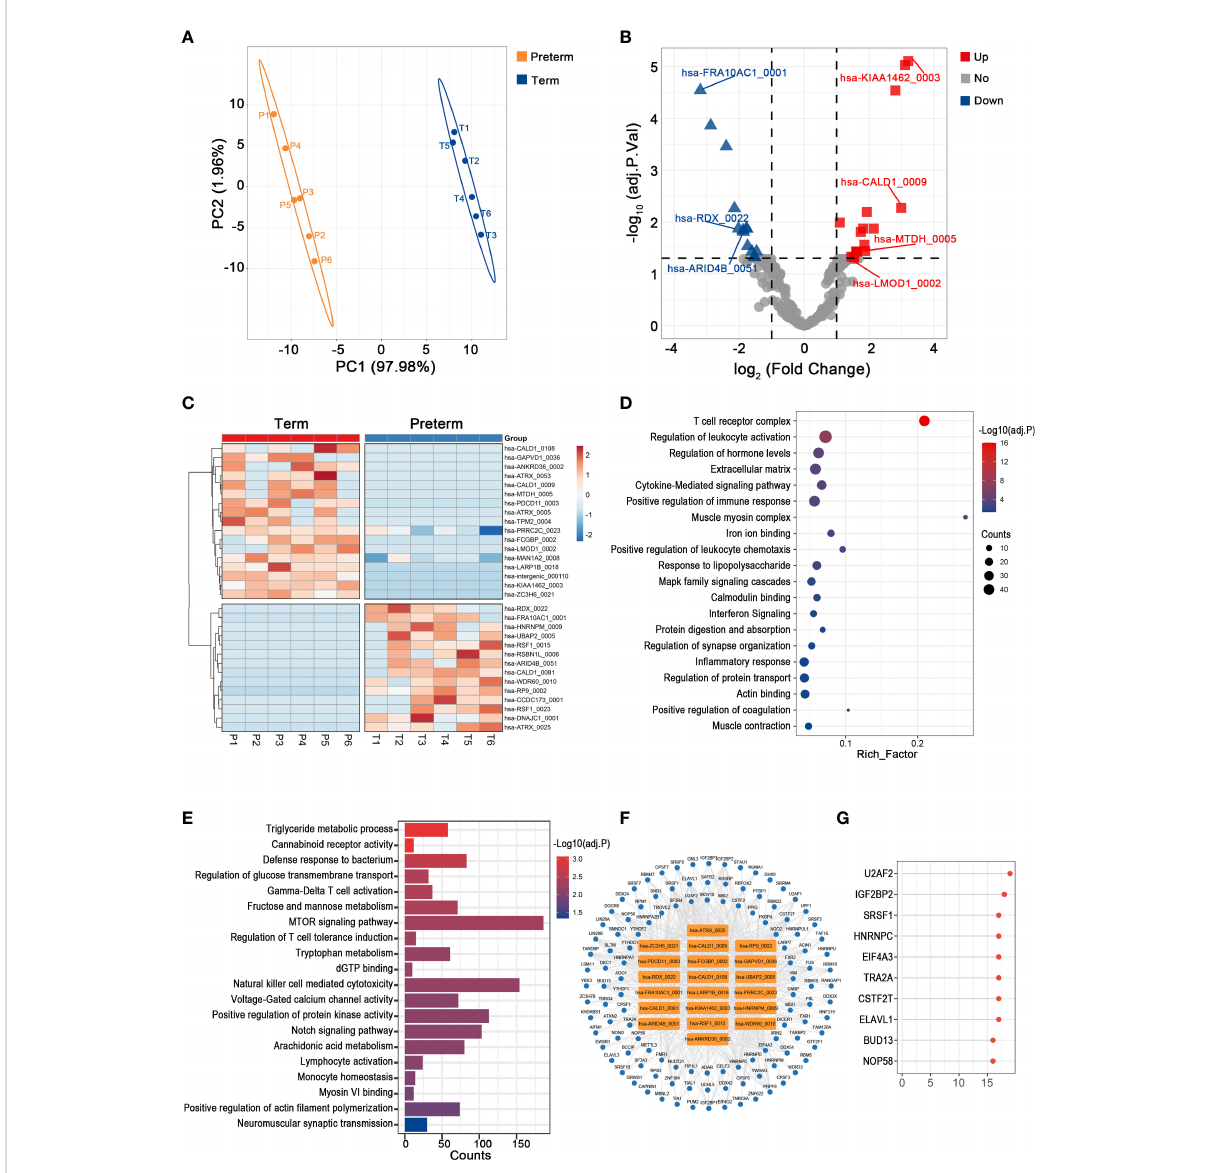
FIGURE 4 The circRNA changes and functional analyses in the myometrium of PTB. (A) PLS-DA of circRNAs expression in preterm (yellow points) and term (blue points) myometrium. (B) The volcano plot of circRNA changes and adj. p-values in the myometrium of PTB. (C) The hierarchical clustering of DECs expression in term and preterm myometrium. (DECs: |log2 (fold change)|> 1 and adj. p-value < 0.05). (D, E) Functional enrichment analysis for co-expressed mRNAs (D) and target miRNAs (E) of DECs in the preterm myometrium. (F, G) The DECs-RBPs network and top 10 RBPs in the